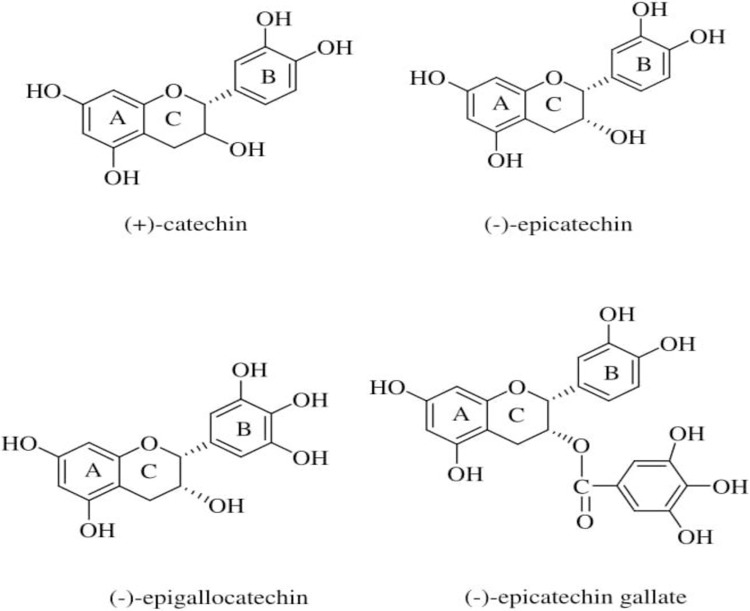
Chemical structure of flavonoid monomers of RMT [17].